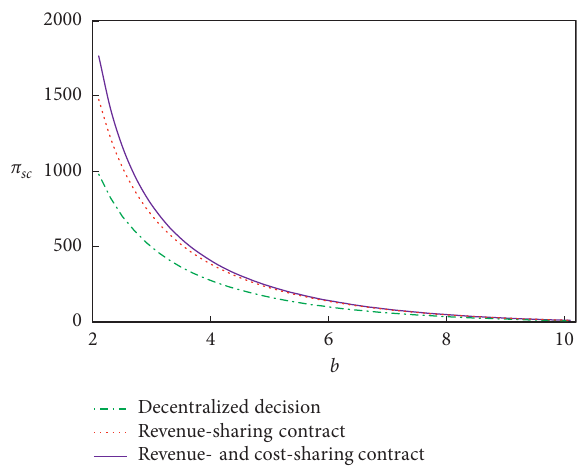
Figure 5: The consumer price sensitivity coefficient’s impact on the supply chain’s profits.